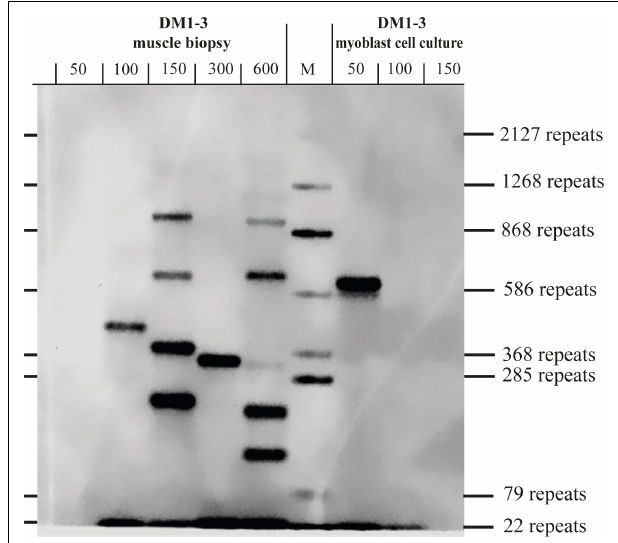
FIGURE 3 | Southern blot comparing DNA derived from a muscle biopsy and a myoblast culture of the same DM1 patient (both samples taken at the same time). For each lane the amount of used DNA in pg (as input for the small pool PCR) is shown. M =